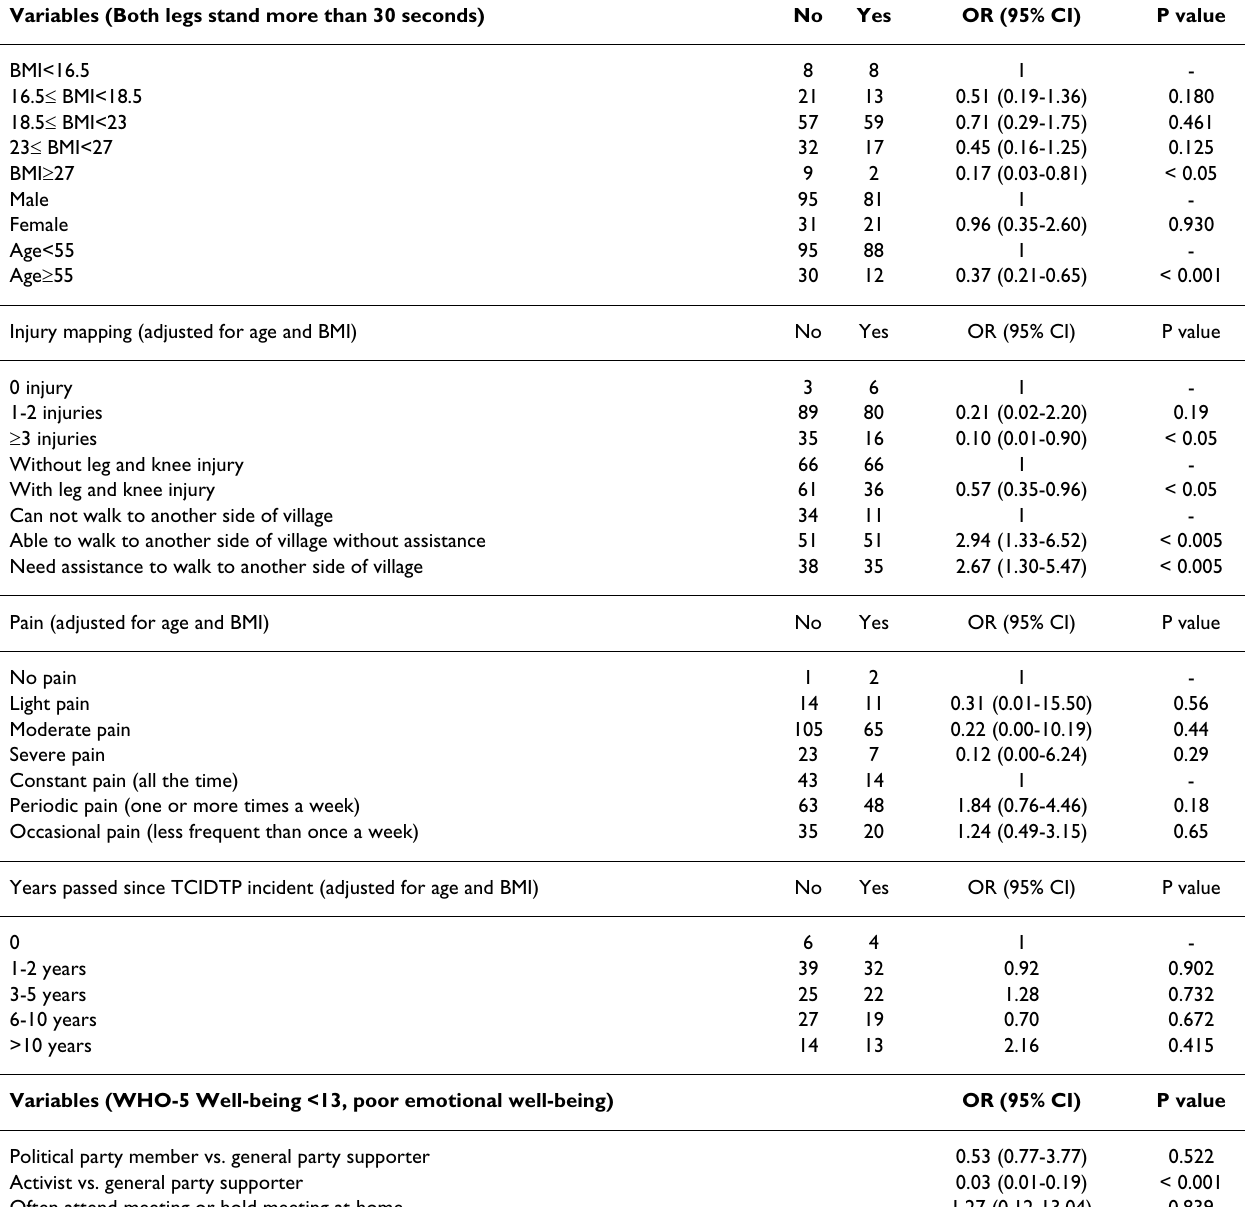
Table 5: Standing balance performance, emotional well-being and its association with personal factors and health condition Variables (Both legs stand more than 30 seconds) No